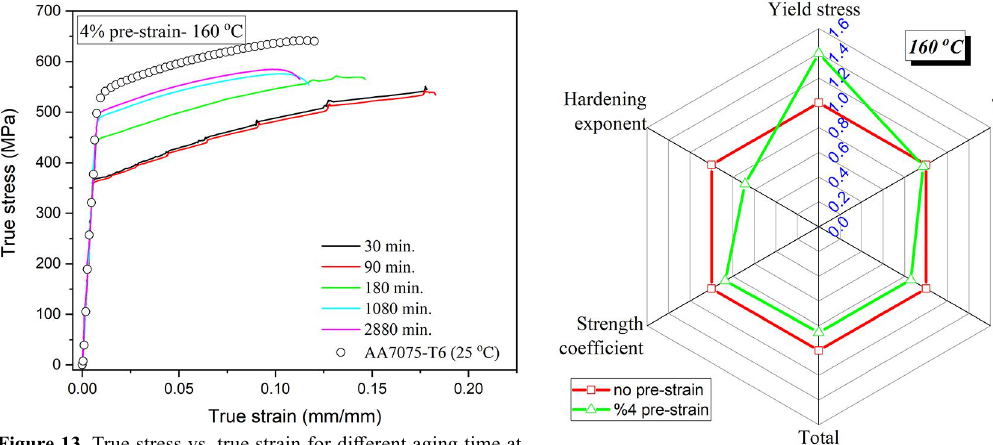
Figure 13. True stress vs. true strain for different aging time at 160 ºC (4% pre-strain)